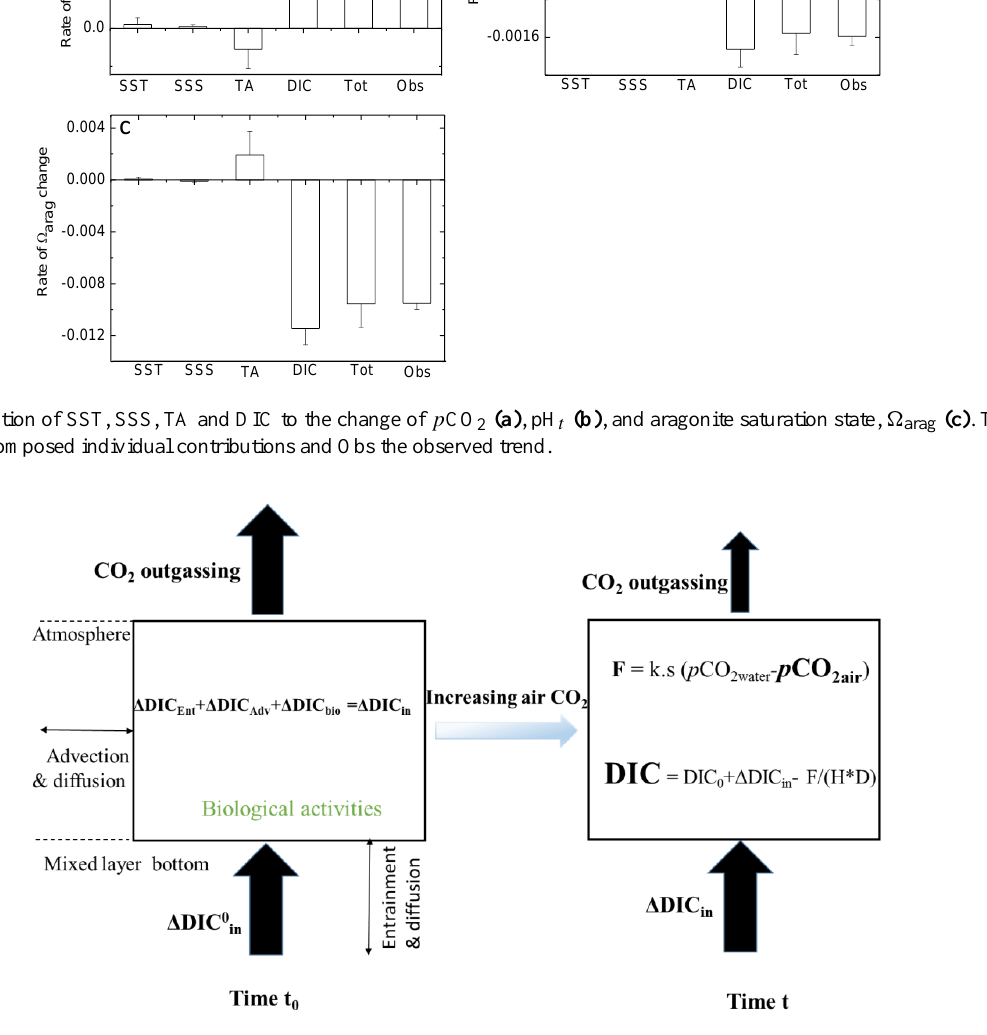
Figure 9. A schematic of DIC increase in the mixed layer induced by atmospheric CO 2 increase in a CO 2 source region with respect to the atmosphere. DIC changes in the mixed layer can be attributed to vertical entrainment ( (cid:49) DIC Ent ), vertical and horizontal advection and diffusion ( (cid:49) DIC Adv ), biological activities ( (cid:49) DIC bio ) and air–sea exchange ( (cid:49) DIC as ). From time t 0 to t when atmospheric CO 2 increases, the driving force of air–sea exchange ( p CO 2 water – p CO 2 air ) and correspondingly the CO 2 outgassing from the ocean to the atmosphere would decrease. This may induce DIC increase in the mixed layer due to reduction in the magnitude of CO 2 source (Schneider et al., 2012). F denotes air–sea CO 2 fluxes, k the gas transfer velocity, s the solubility coefficient of CO 2 , and p CO 2 water and p CO 2 air are the p CO 2 in the surface ocean and in the atmosphere. Details on air–sea CO 2 fluxes can be found in Sect. 2.3. H and D are mixed layer depth and seawater density,